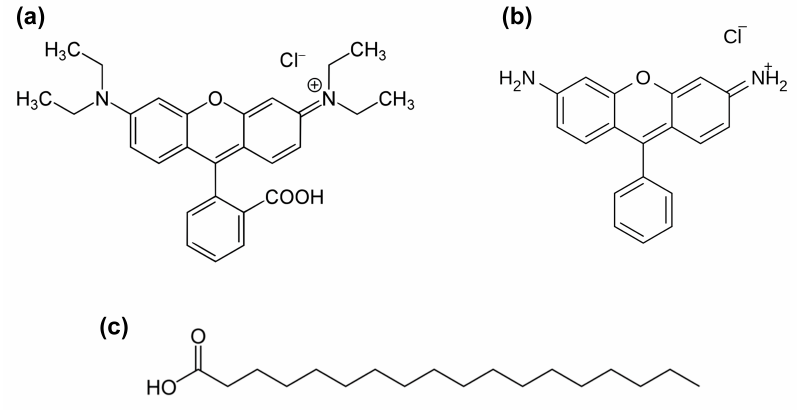
Figure 6. Chemical structure of Rhodamine B ( a ), Rhodamine 110 ( b ), and stearic acid ( c